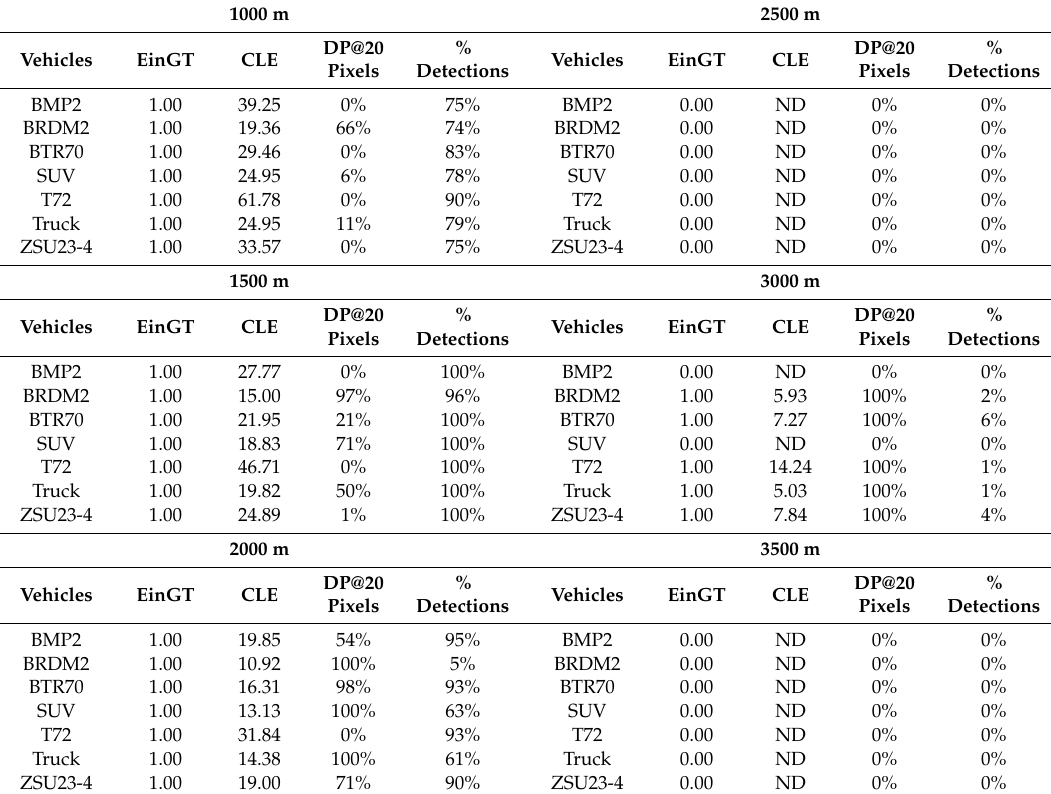
Table A1. Tracking metrics for PCE 50 (optical video). ND means “no